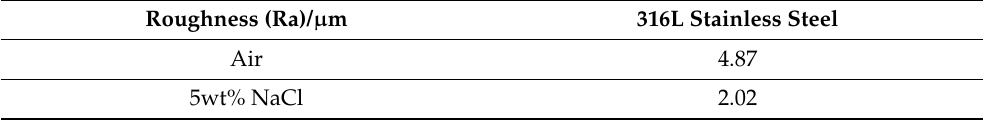
Table 7. Fatigue fracture roughness of 316L stainless steel in air and 5wt% NaCl. Roughness (Ra)/μm